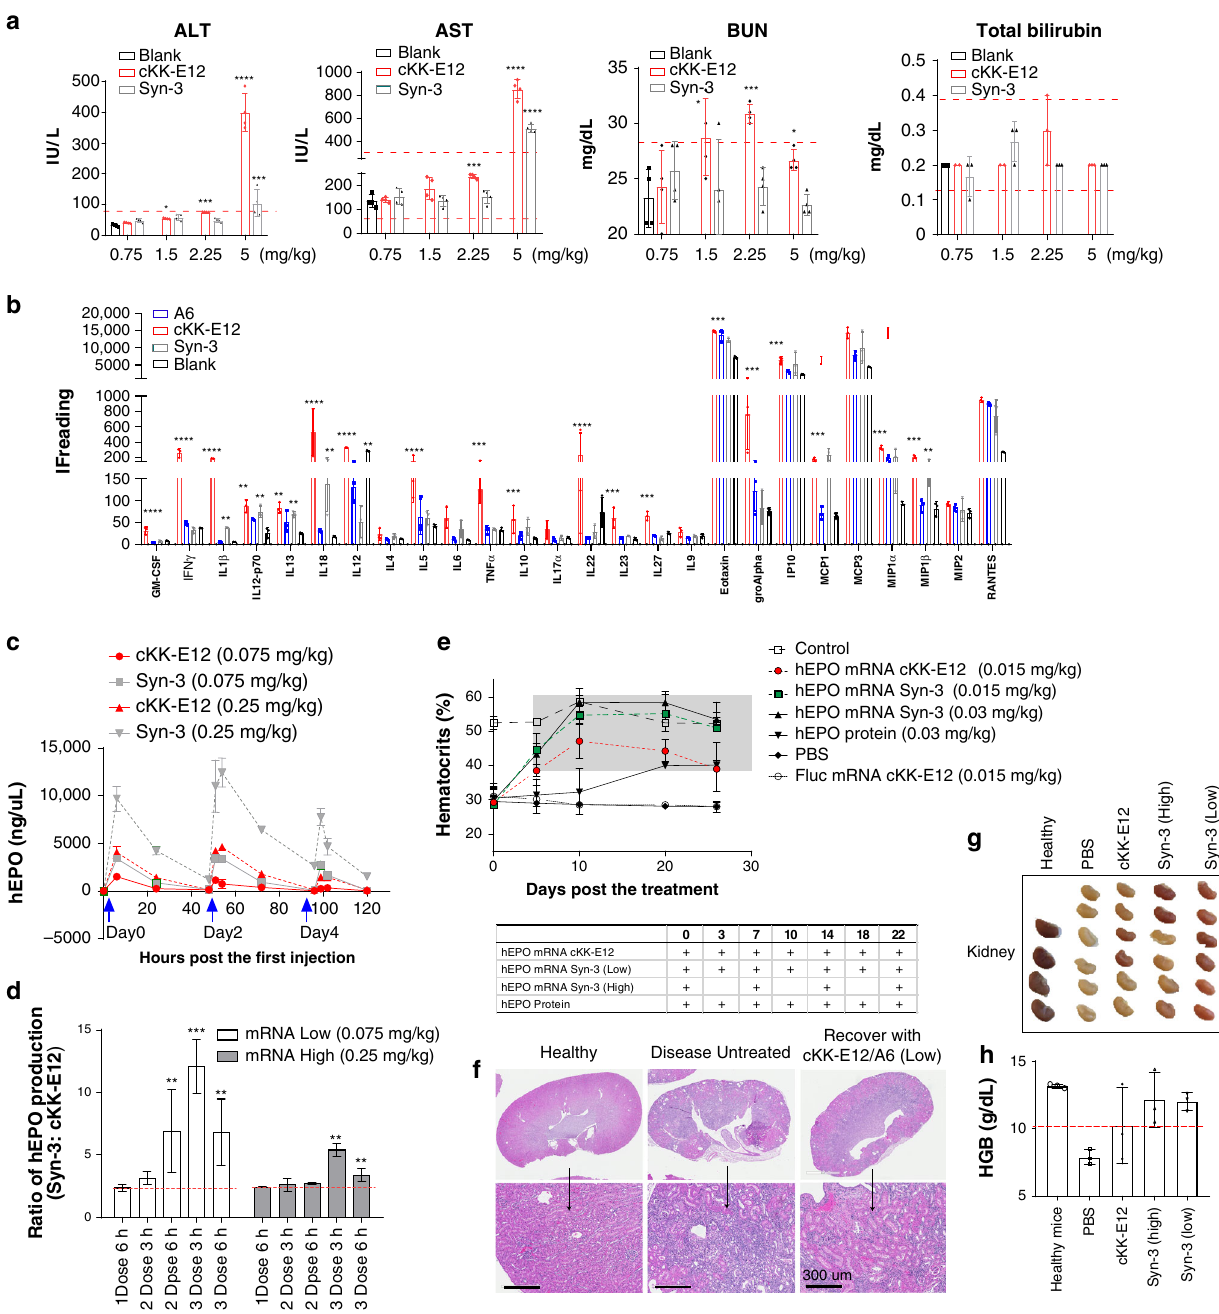
Fig. 4 Tolerability and multiple dosing ef fi cacy of synergistic LNPs. a Dose-dependent blood chemistry assay demonstrated decreased toxicity of Syn-3 LNPs as compared with cKK-E12 LNPs with relatively low values of AST, ALT, BUN, and total bilirubin ( n = 4/group), Student ’ s T-test comparing to blank. b The multi-plex cytokine assay of blank LNPs (equivalent to 1.5 mg/kg mRNA LNPs) after single dose ( n = 4/group), Student ’ s T-test comparing to blank. c mRNA expression kinetics after multiple dosing of mRNA containing LNPs. Protein expression ratio of Syn-3 LNPs were compared with mono cKK-E12 LNPs at different time points ( n = 4). d Student ’ s T-test comparing to 1 Dose 6 h. e treatment of renal anemia by different forms of hEPO containing LNPs ( n = 6 – 8). f , g Morphology and structure of kidney after treatments. h HGB levels were also compared in different groups ( n = 6). Data are presented as mean ± SD. * P < 0.05, ** P < 0.01, *** P < 0.001, **** P <